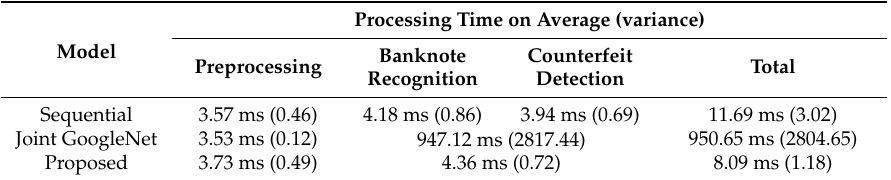
Table 4. Mean and variance of inference